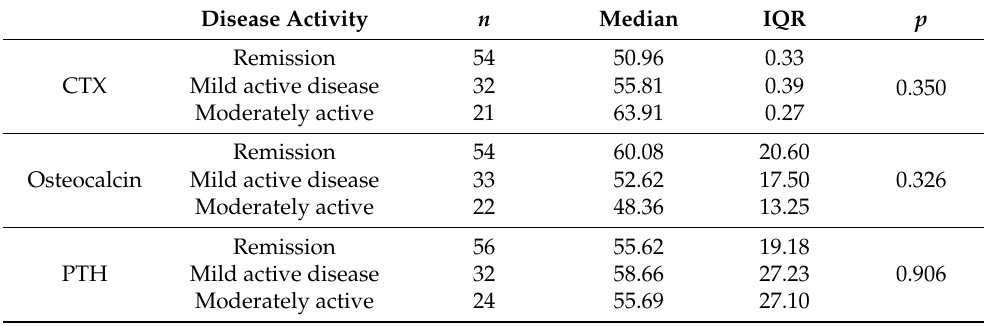
Table 7. Differentiation of CTX, osteocalcin and PTH depending on disease activity in CD.